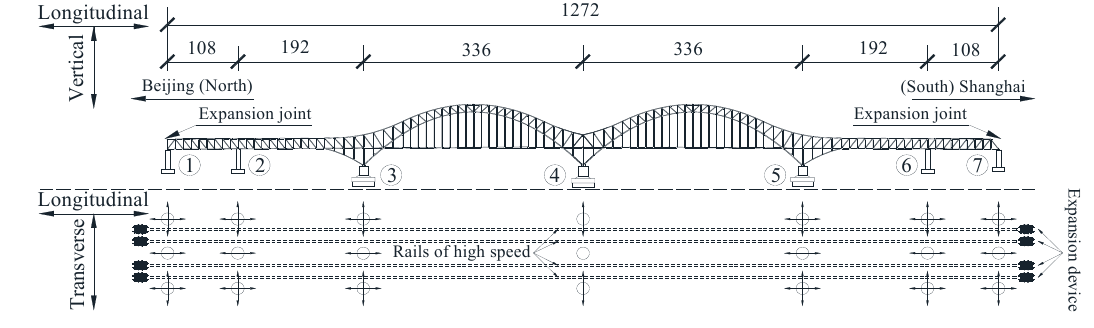
Figure 1. Bridge and its bearings and expansion devices (units: meters).